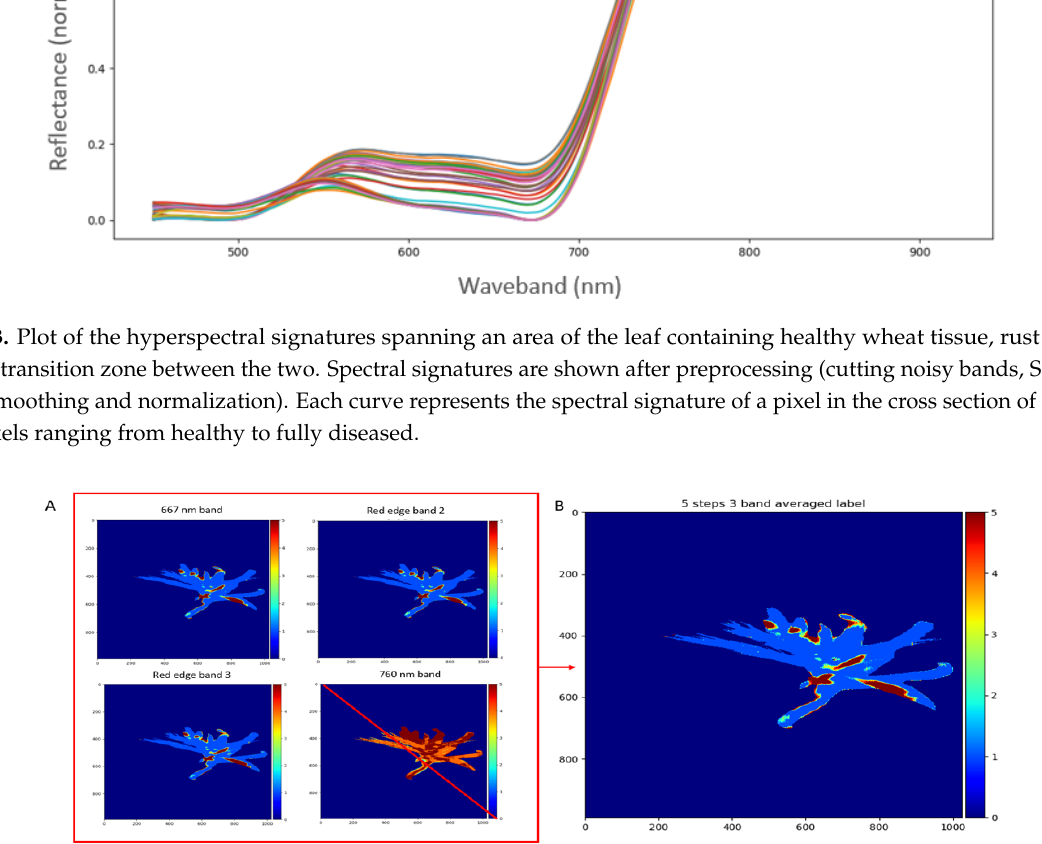
Figure 4. Example of the automatic labelling algorithm. The colour bar represents the label given by the automatic labelling algorithm. labelling